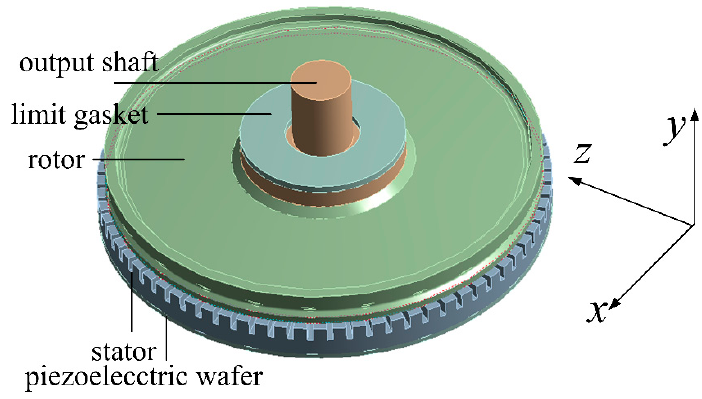
Figure 2. Finite element model.